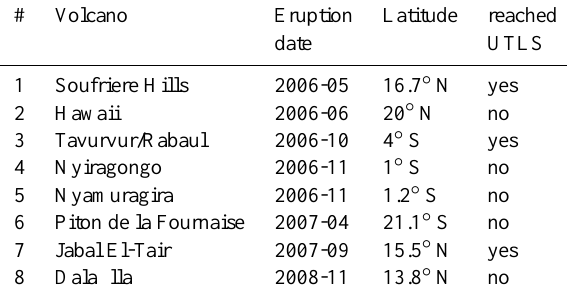
Table 4. Eruptions considered in the